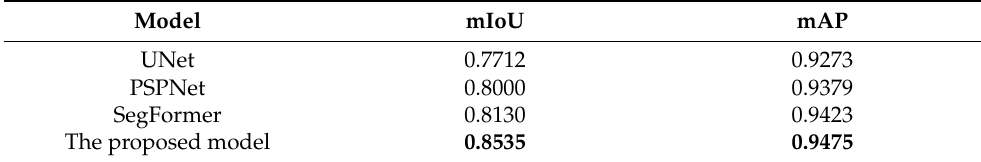
Table 4. Performance comparison on the dataset between different models.